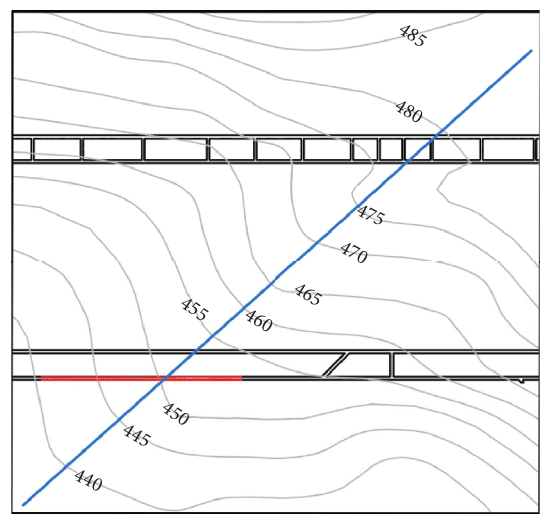
Figure 4: The anticlinal structure distribution of N2105 working